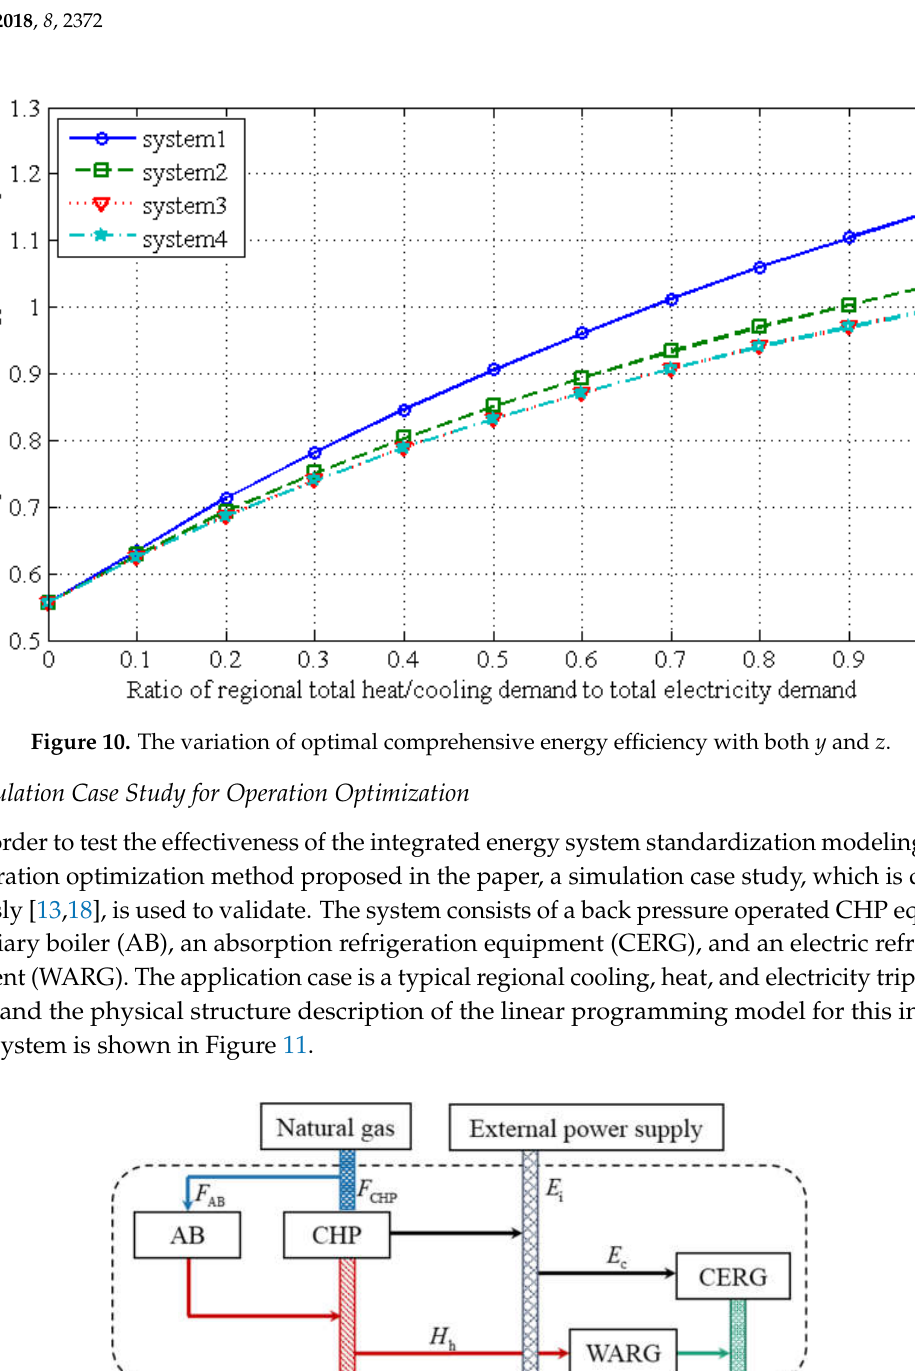
Figure 9. The variation of optimal comprehensive energy efficiency with z.